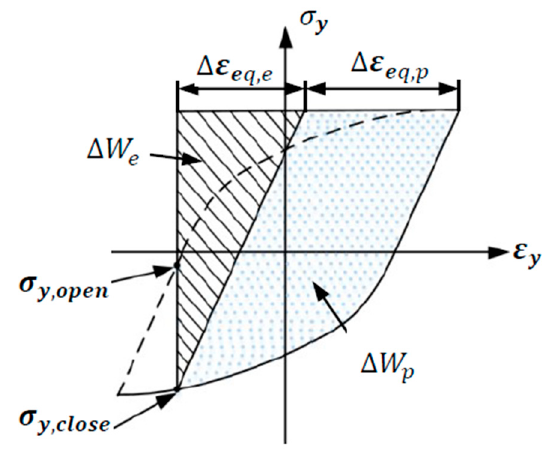
Figure 9. Effective elastic and plastic energy density [15]. Figure 9. E ff ective elastic and plastic energy density